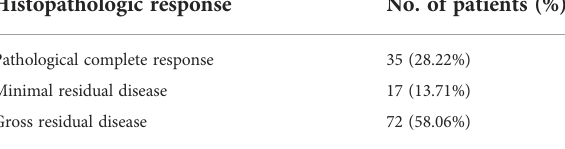
TABLE 2 The results of pathological response of all patients.